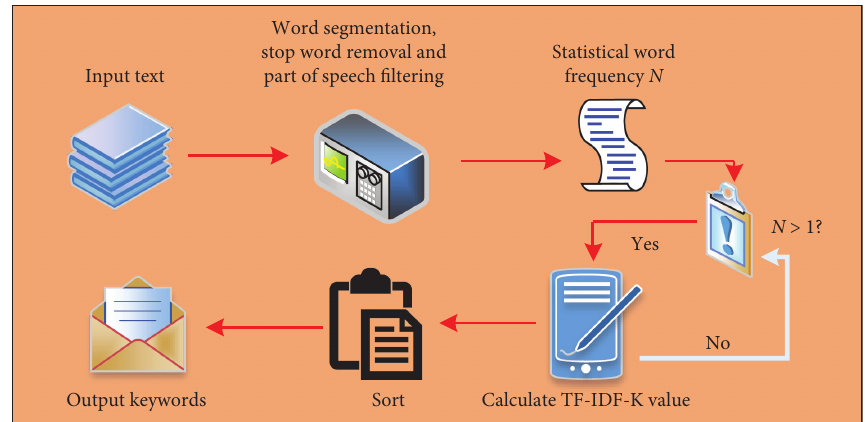
Figure 3: Algorithm flow chart.